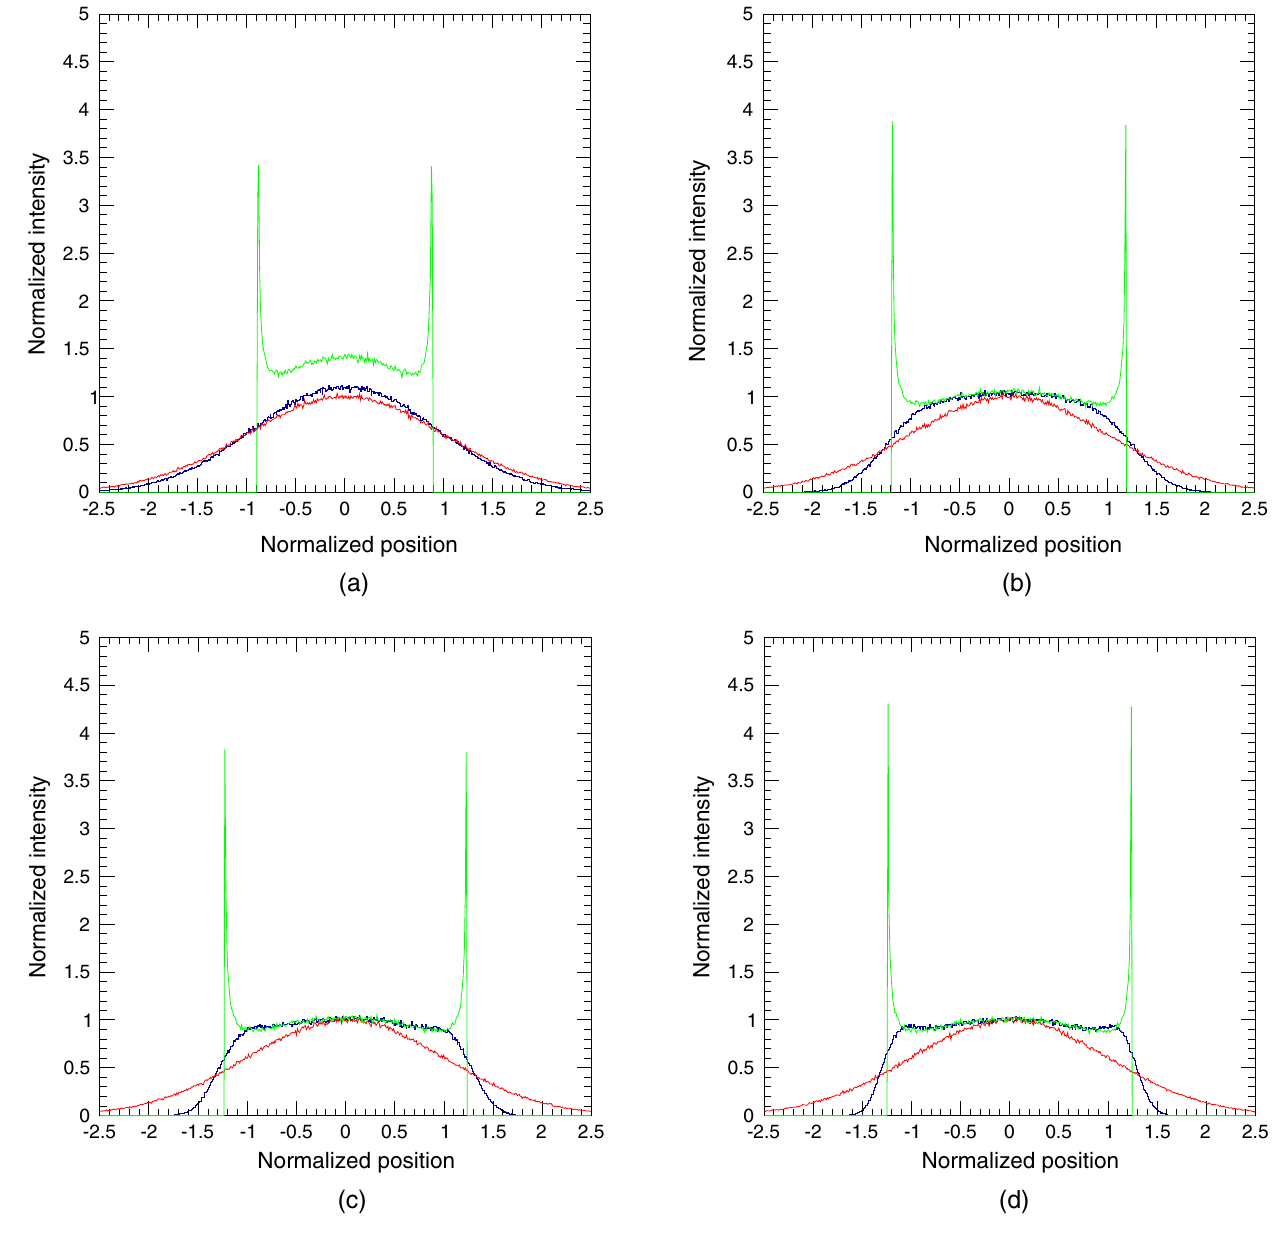
FIG. 23. Transverse beam distribution obtained by tracking for various phase advance (black lines) of cot ϕ ¼ 1 , 3, 5, and 7 shown in panels (a) – (d), respectively, with Gaussian-normalized phase space distribution. The red line shows the profile obtained with linear optics, and the green line shows the result obtained using the filament